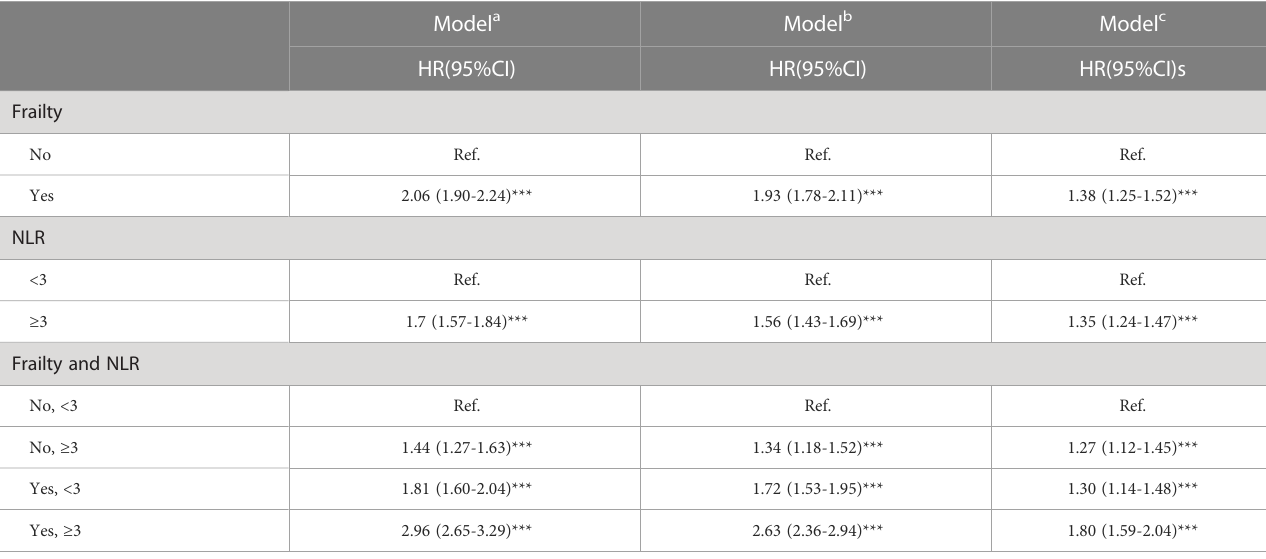
TABLE 2 Systemic In fl ammation (NLR), frailty, and survival in elderly patients with